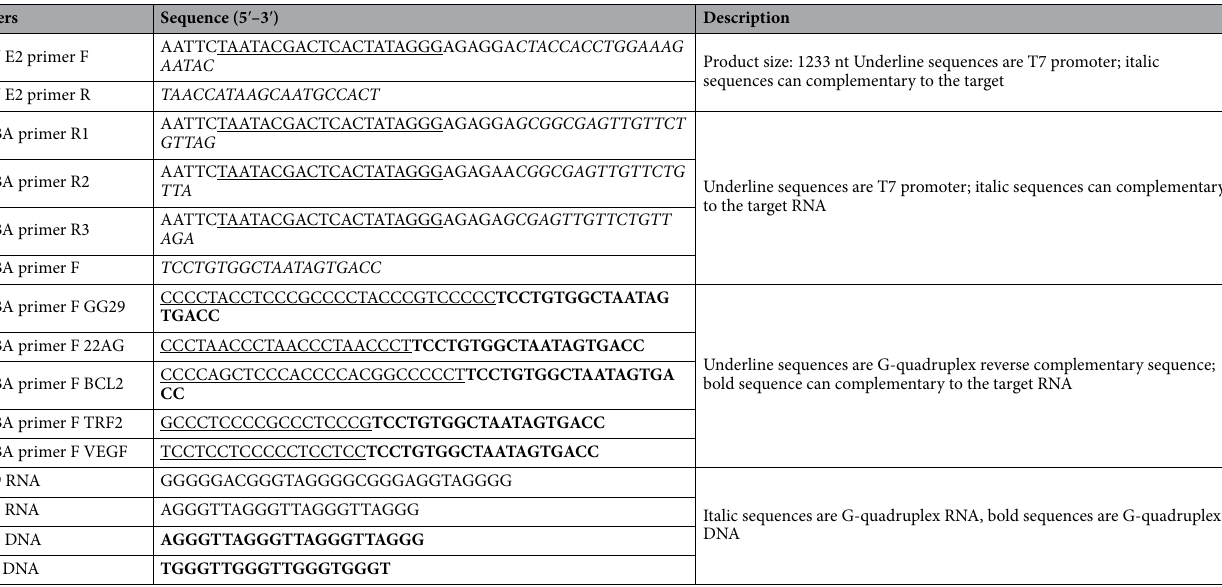
Table 1. List of primers and probes for CSFV detection by G4-ThT-NASBA